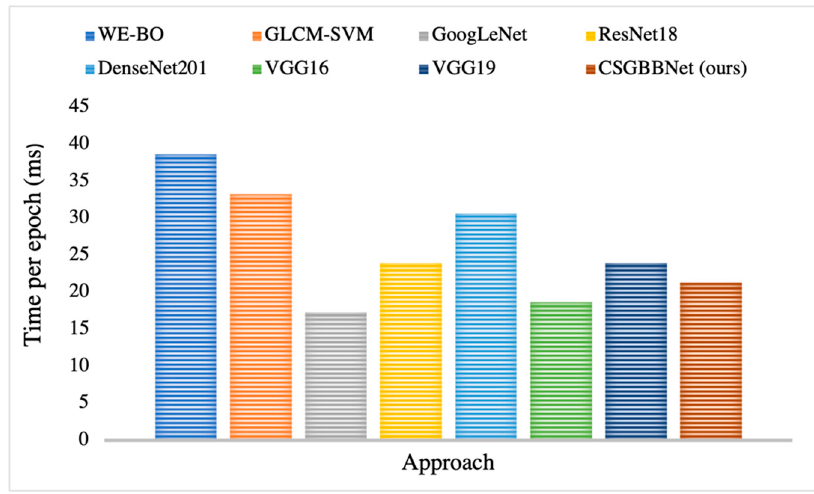
Figure 15. Per-epoch training time of CSGBBNet vs. other seven methods.